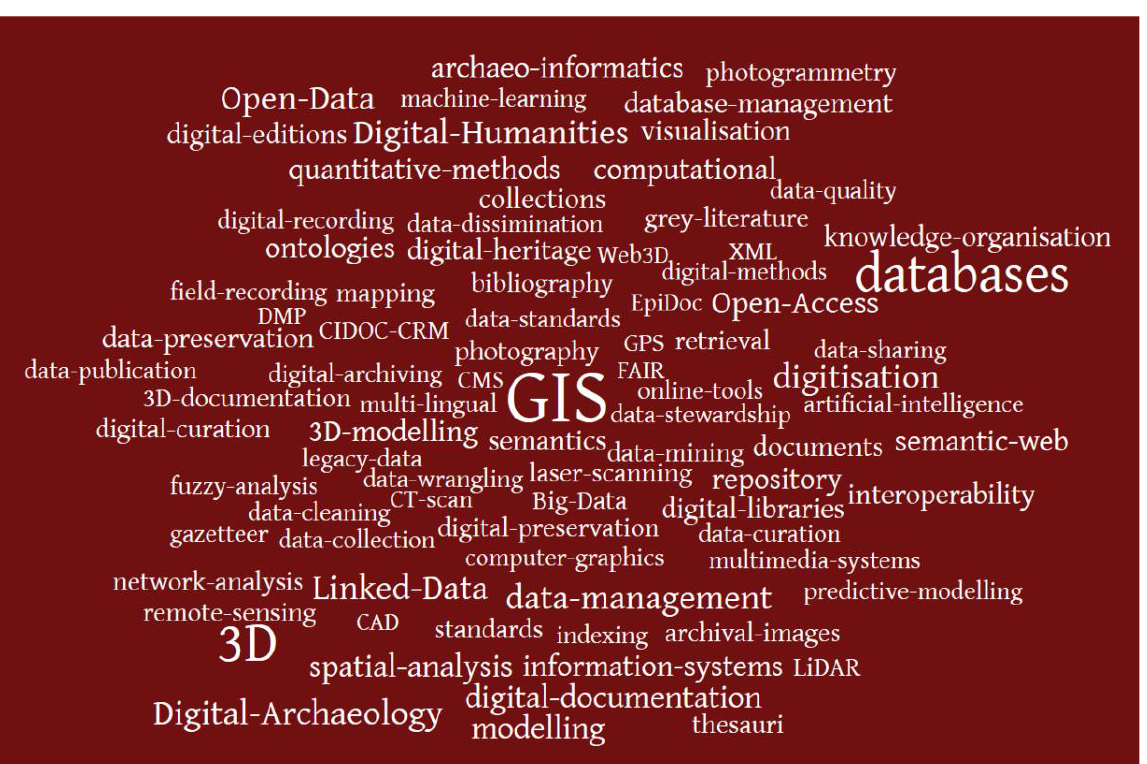
Figure 3 : Word cloud of 85 terms for data-related and other digital systems and